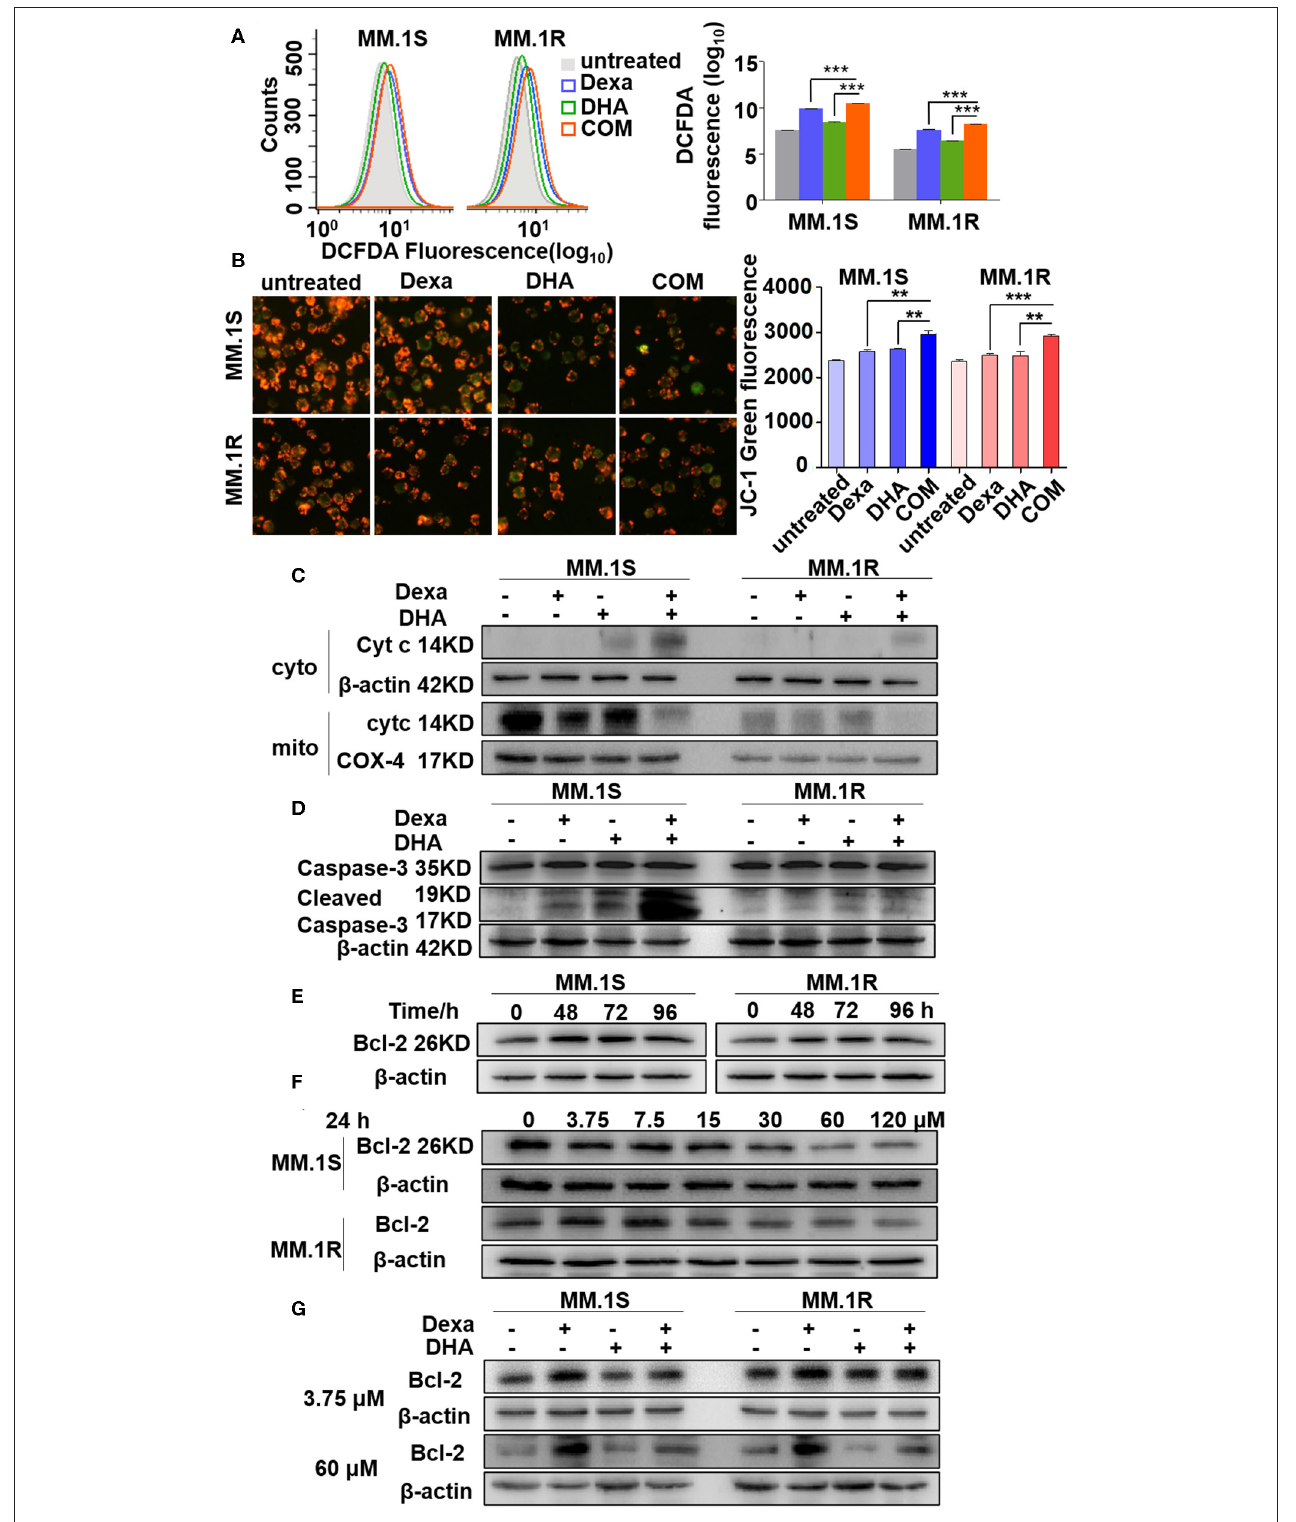
FIGURE 5 | DHA in combination with Dexa induced more translocation of Cyt C from the mitochondria to the cytoplasm. (A,B) Determination of ROS and mitochondrial membrane potential. Fluorescence intensity is detected by flow cytometry. (C–G) The western blotting results showed that Cyt C and cleaved caspase-3 are increased after treatment with DHA plus Dexa and Bcl-2 expression is associated with Dexa administration in a time- and concentration-dependent manner. ** P < 0.01, *** P < 0.001.